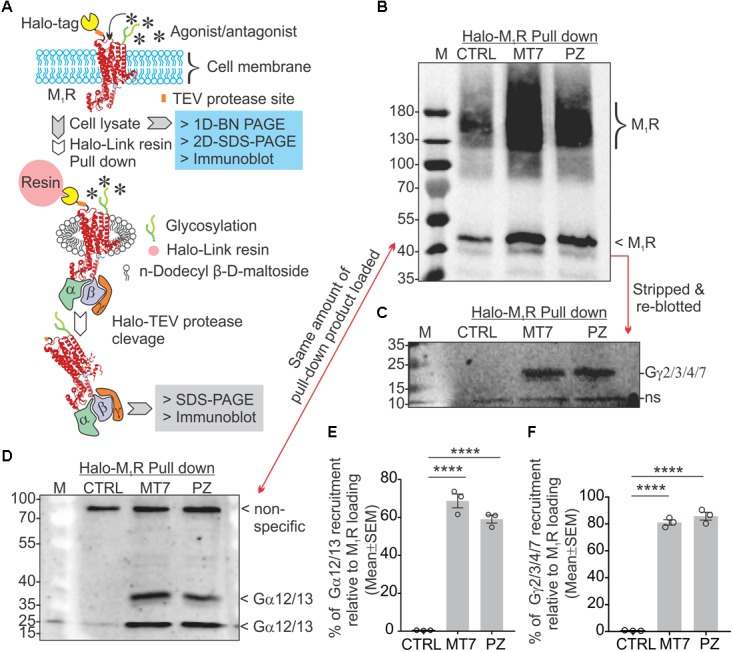
MT7 and pirenzepine elevated sequestration of trimeric G proteins associated with M1R in SH-SY5Y cells. (A) Diagrammatic representation of the experimental strategy. (B–D) Halo-tagged M1R was expressed transiently in sensory neurons and then treated with 100 nM MT7 or 1 μM PZ for 1 h. Cells were then lysed and Halo-M1R was pulled down using halo-linked resin. The halo tag was cleaved by TEV protease and the cleaved M1R associated multiprotein complex (MPC) was resolved in denaturing SDS-PAGE and immunoblotted using (B) anti-M1R, (C) anti-Gγ2/3/4/7, and (D) anti-Gα12/13 antibodies. (E,F) Scatter plot showing the relative amount of G proteins (Gα and Gγ, respectively) associated with M1R following drug treatment. The data represent mean ± SEM of three independent experiments. p-values (∗∗∗∗<0.0001) were calculated by one-way ANOVA with Dunnett’s post hoc multiple comparison test.